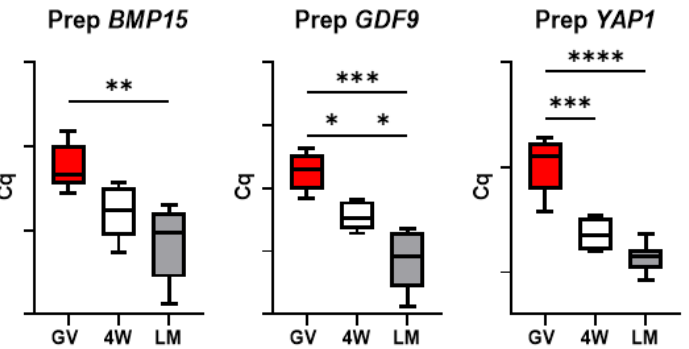
Figure 6. Expression of oocyte-secreted factors in pools of prepubertal GV and MII oocytes matured in 4-well plates (4W) or in liquid marbles (LM). Target gene expression was normalized against the luciferase exogenous control. Relative abundance is expressed as ∆ Cq ( Y -axis). Each box represents the mean expression of 5 replicate pools of 10 oocytes each (mean ± SE). Significant differences were assessed by ANOVA general linear model test; * p < 0.05, ** p < 0.01, *** p < 0.001, **** p <